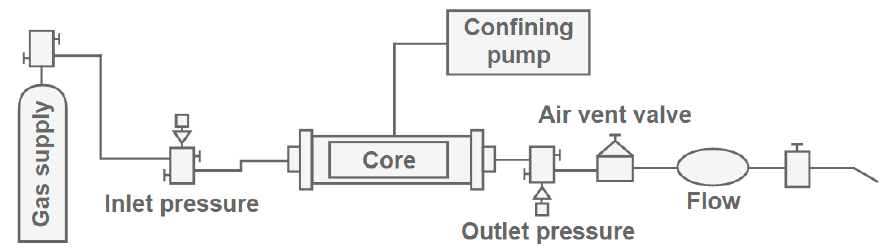
Figure 1. Experimental procedures.